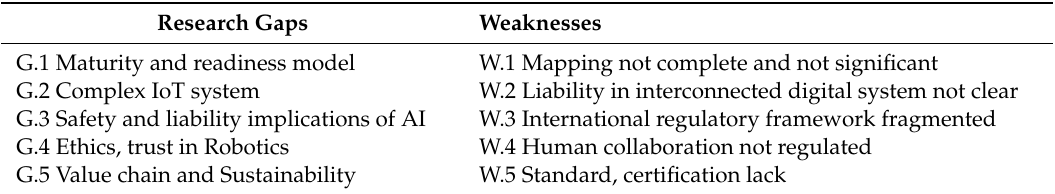
Table 5. Research gaps and